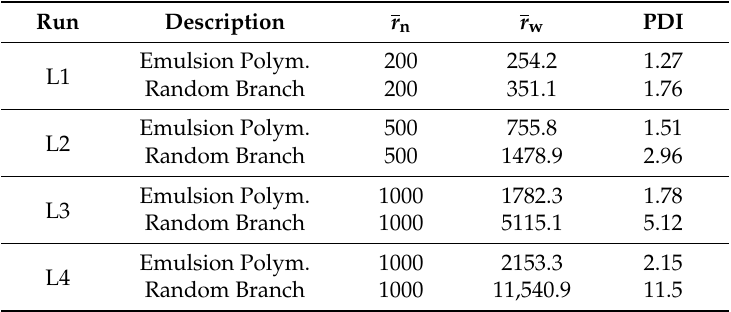
Table 6. Comparison of the calculated average chain lengths for living FRP.